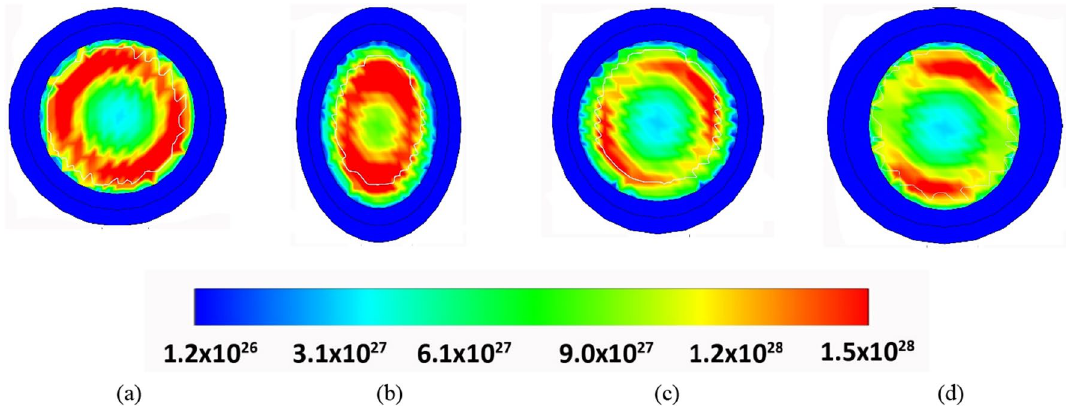
Figure 8. Band generation rate of carriers for ( a ) COCC, ( b ) EOEC, ( c ) EOCC, and ( d )